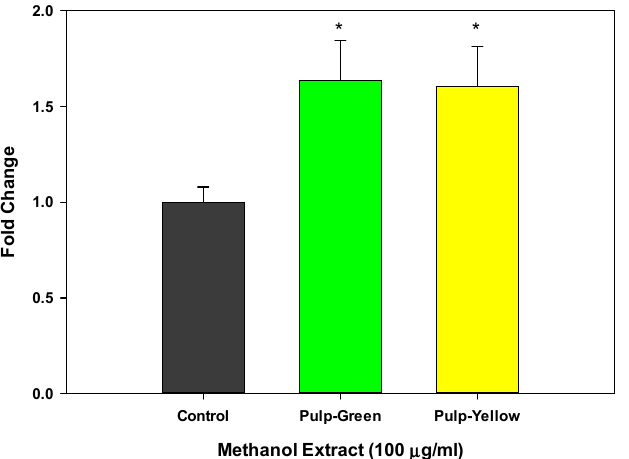
Figure 6. Effect of papaya pulp on Glut-2 expression. The expression of Glut-2 was determined using ELISA following steps as described in the text (ThermoFisher protocol) and values were normalized for protein concentration using a Pierce™ BCA Protein Assay Kit (ThermoFisher). The data were expressed as % change from vehicle-treated control cells. The statistical analysis was performed using Student’s t test between control and green or yellow papaya. The significant difference is represented by “*” at p < 0.05.